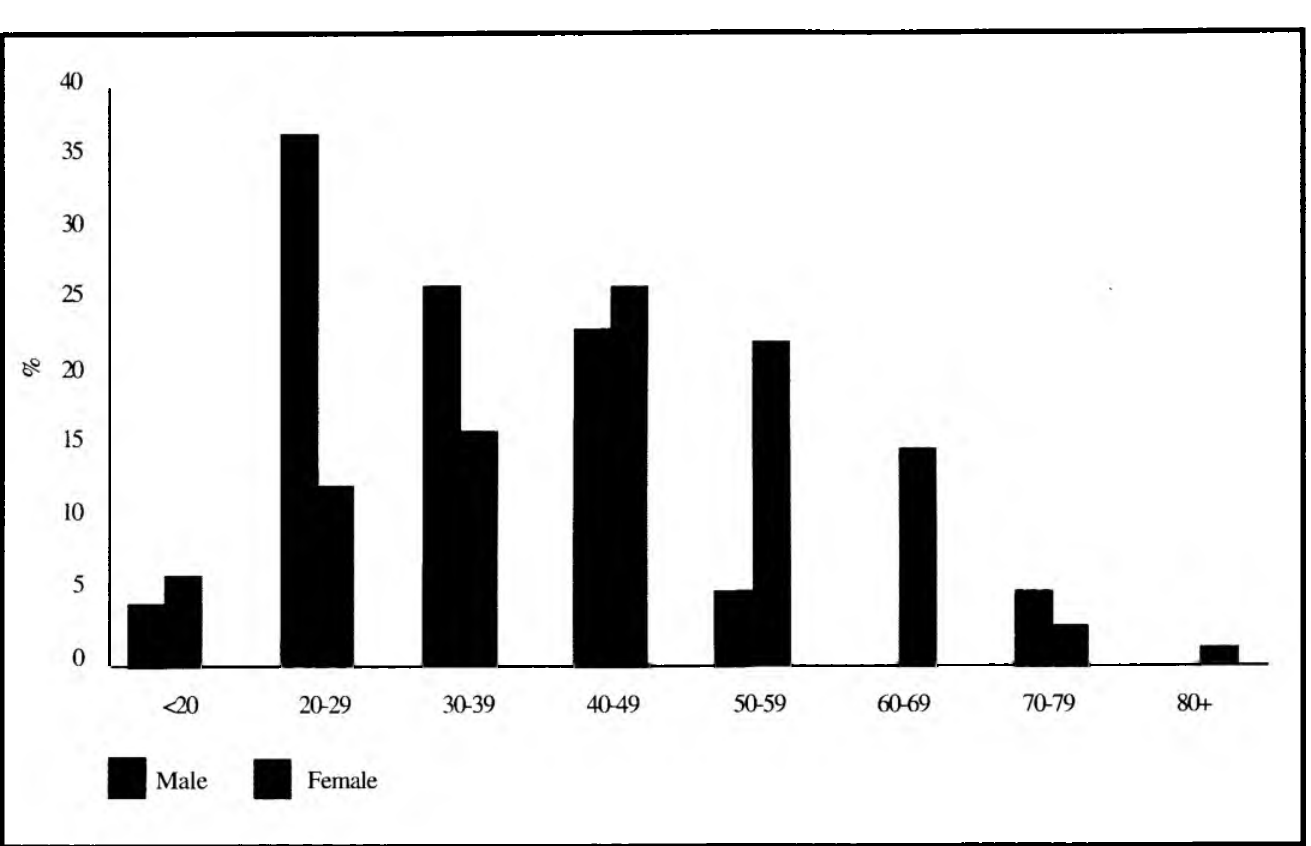
FIGURE 2: Hypertension cross tabulated with age groups (%)